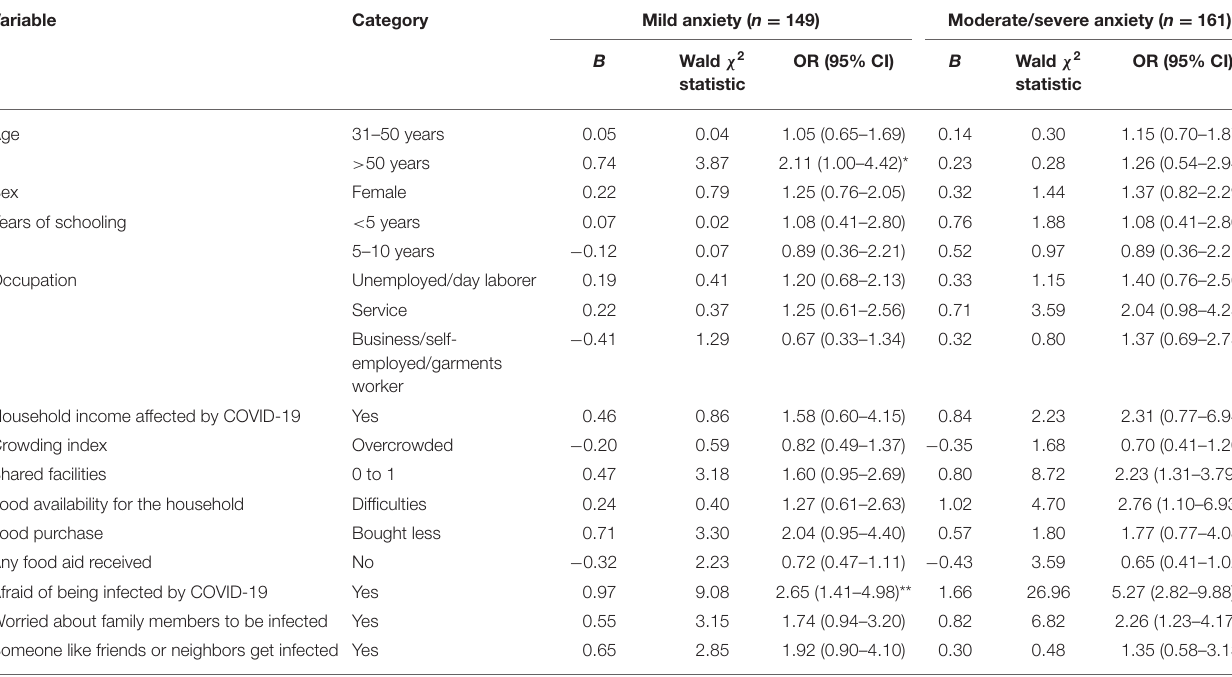
TABLE 4 | Multinomial logistic regression differentiating minimal anxiety ( n = 276) from mild and moderate/severe anxiety.